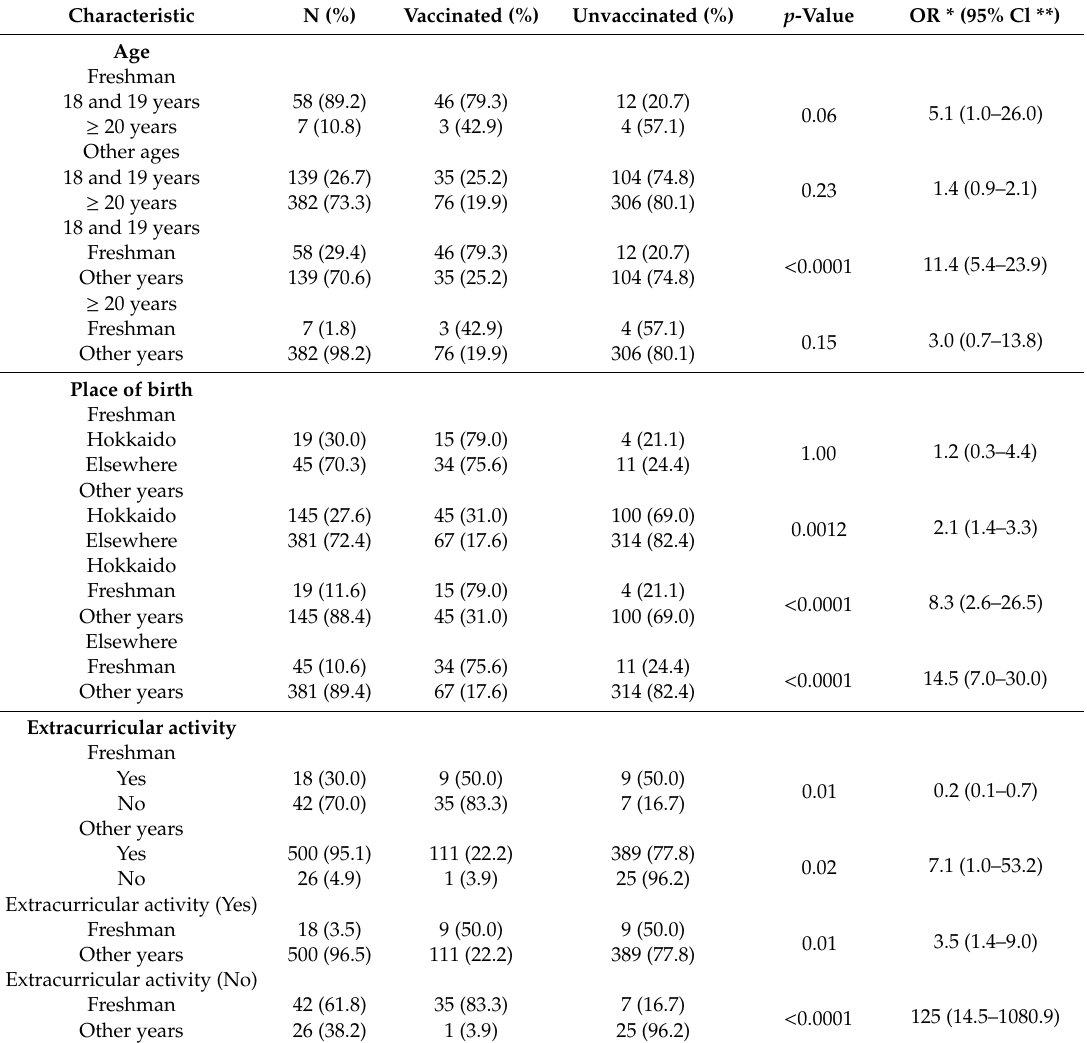
Table 3. Cross tabulation of the frequency of vaccination, regarding age, grade / year, birthplace, and extracurricular